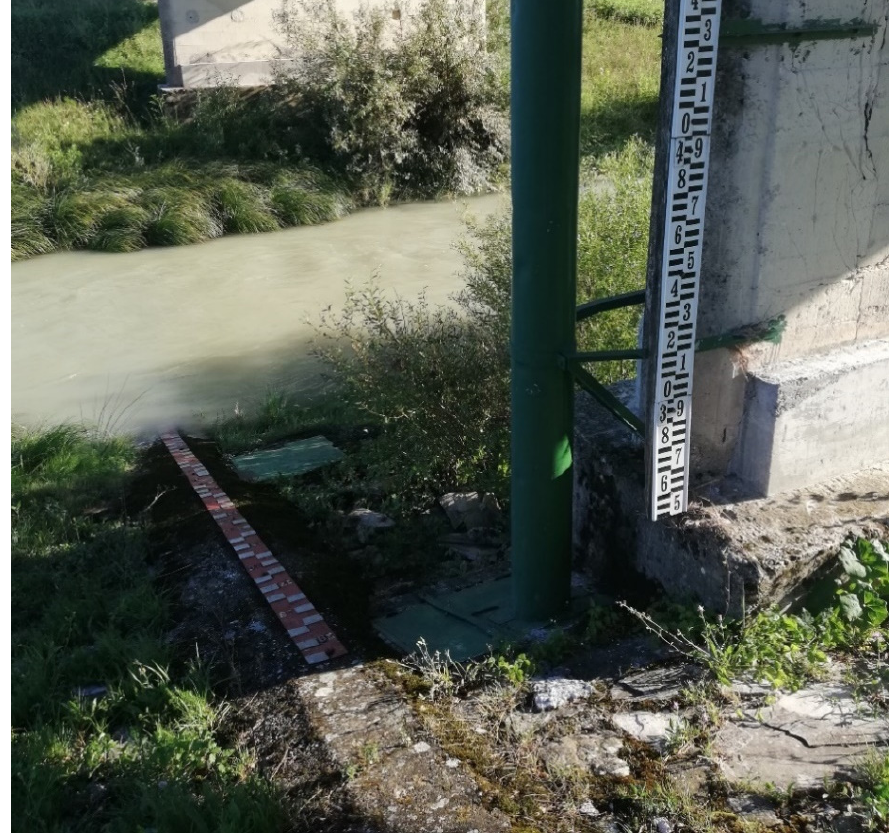
Figure 10. View at the measuring station of Motovun on the river Mirna.